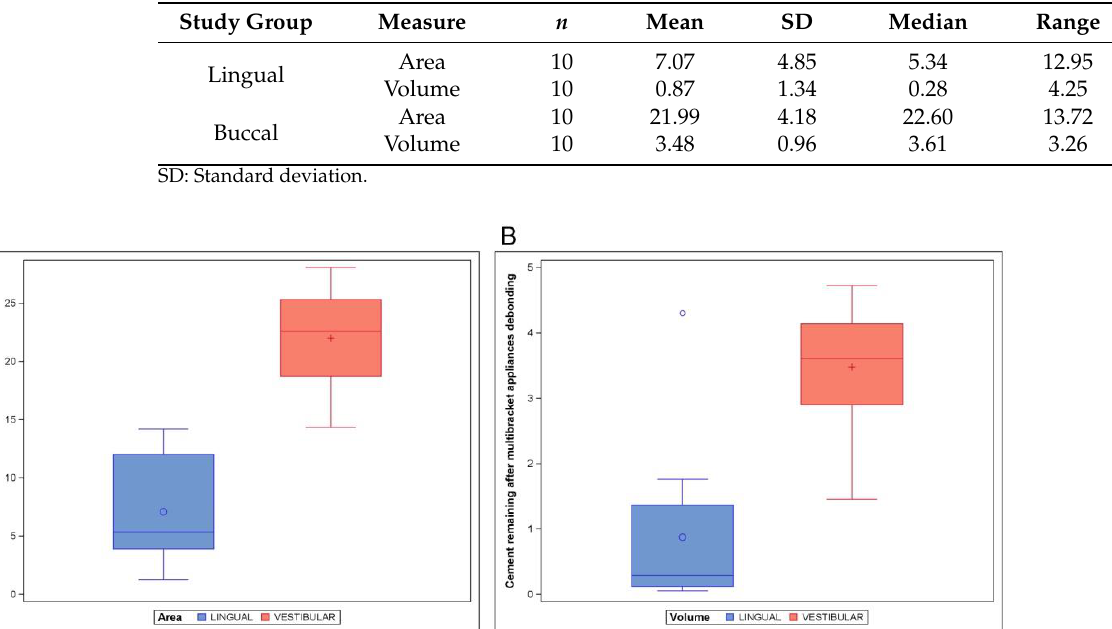
Table 2. Descriptive statistics of the area (mm 2 ) and volume (mm 3 ) of remaining cement after ce- ment polishing of the lingual and buccal multibracket appliance therapies.